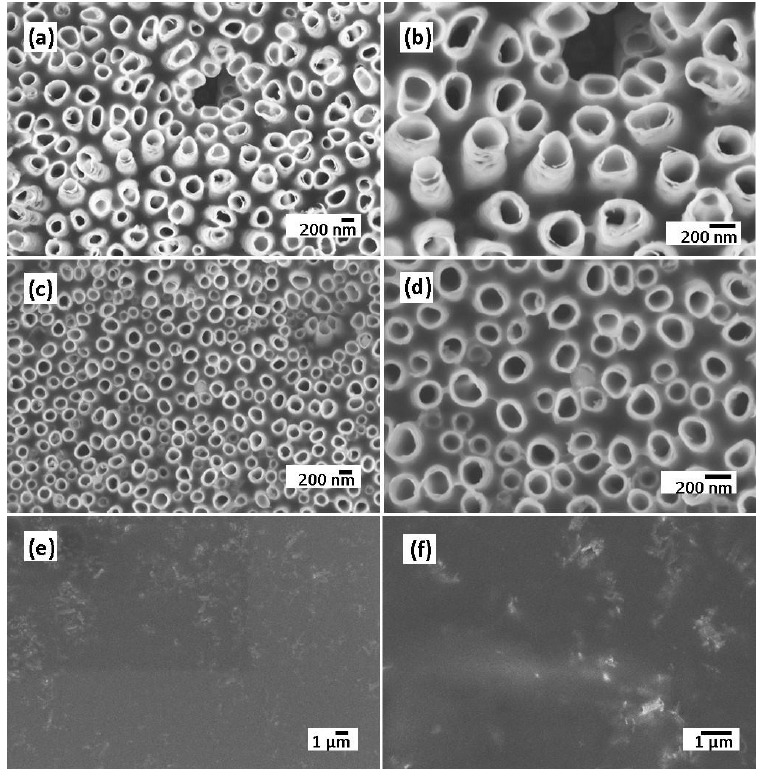
Figure 4. SEM images of TiO 2 NTs electrode at low and high magnifications after 5 cycles ( a , b ), 10 cycles ( c , d ), and 25 cycles of CV ( e , f ). 10 cycles ( c , d ), and 25 cycles of CV ( e , f